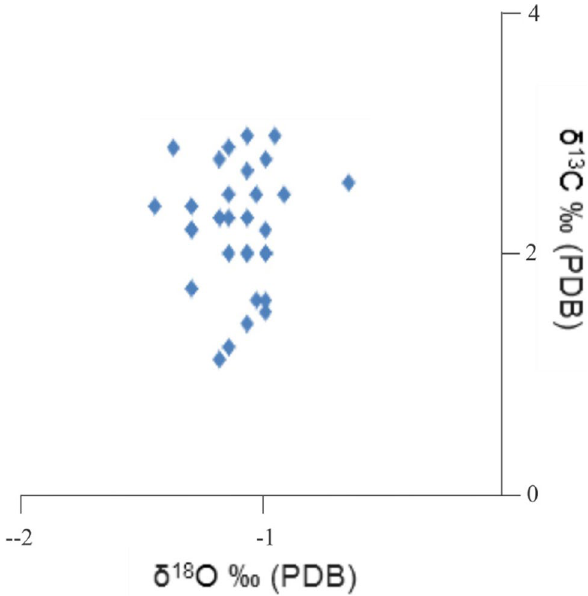
Fig. 7 Cross plot δ 18 O vs. δ 13 C shows near-surface precipitation of